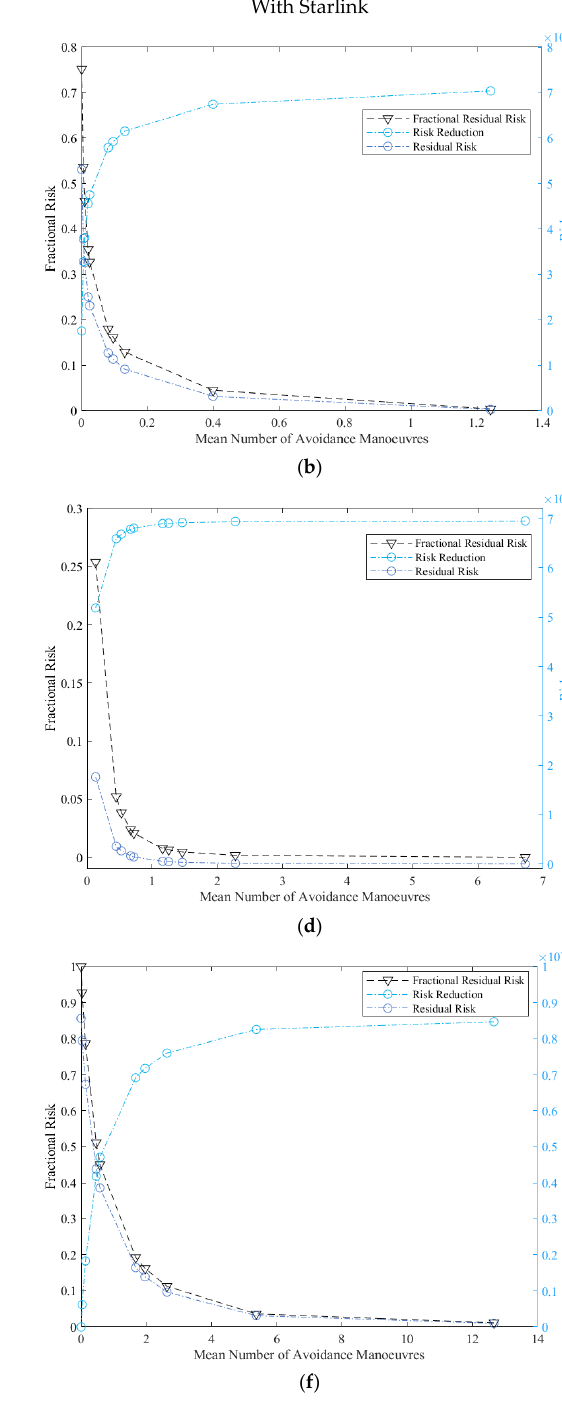
Figure 8. Average number of operations vs. residual risk. ( a , b ) The variation of GAOFEN satellites in fractional risk and risk to different Mean Number of Avoidance Manoeuvres With Starlink and Without Starlink; ( c , d ) The variation of CORVUS BC5 satellites in fractional risk and risk to different Mean Number of Avoidance Manoeuvres With Starlink and Without Starlink; ( e , f )The variation of YAOGAN −35C satellites in fractional risk and risk to different Mean Number of Avoidance Manoeuvres With Starlink and Without Starlink.